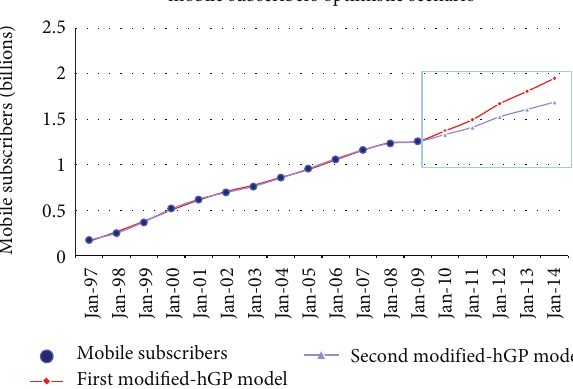
Figure 38: The forecasting performance (5 years ahead) of modified-hGP models—the optimistic